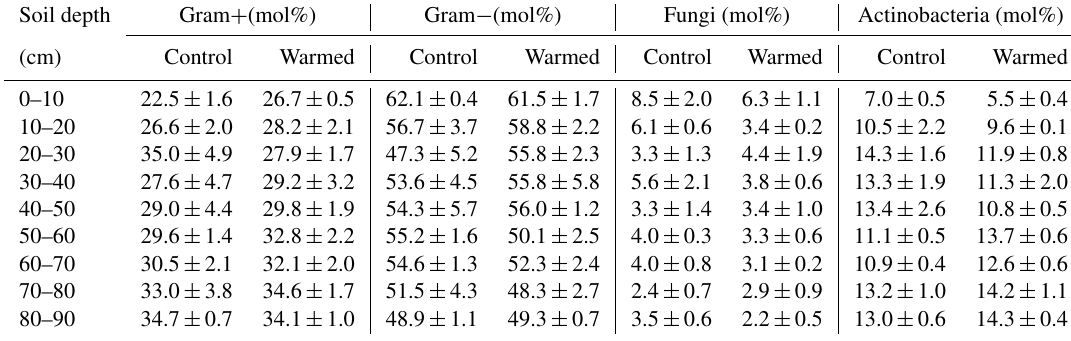
Table B3. Relative abundance of microbial groups, identified using PLFAs in control plots and warmed plots (mean ± SE; n =